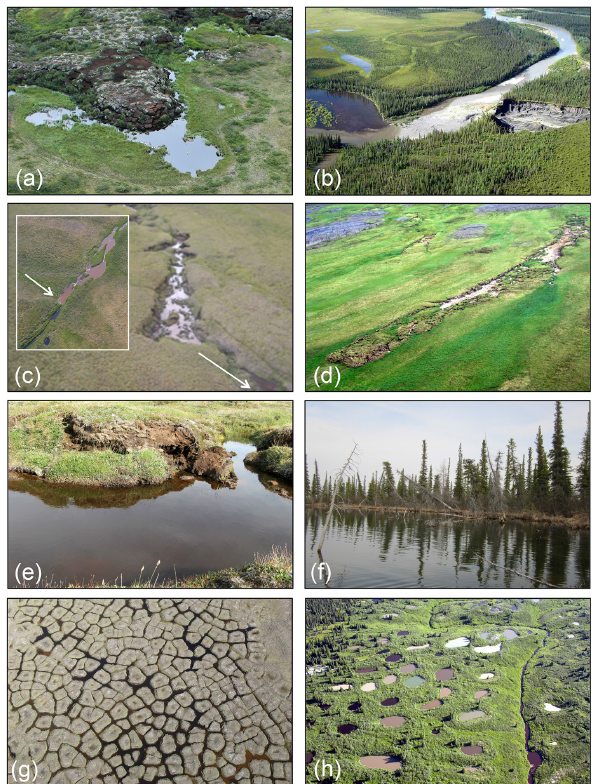
Figure 2. Photos of typical thermokarst processes: (a) Thermokarst lake SAS1, located in a sub-Arctic peat bog near Kuujjuarapik– Whapmagoostui, Québec, Canada. The water body lies next to a thawing, organic-rich palsa (permafrost mound), and is 25m in its maximum dimension. (b) Massive thaw slump on the Selawik River near Selawik, Alaska, US. Sediment discharge from the fea- ture has entirely blocked the river. Note the turbidity downstream. (c) Gully thermokarst on the Toolik River, Alaska, US, and im- pact on receiving stream (inset), (d) active layer detachment slides near the Anaktuvuk River burn area on the North Slope of Alaska, (e) trough pond on Bylot Island, Nunavut, Canada featuring active erosion, (f) thermokarst lakes in Mackenzie Delta, Northwest Ter- ritories, Canada, showing active shoreline slumping, (g) polygonal landscape on Bylot Island, showing ice-wedge trough ponds, and (h) thermokarst lakes and ponds with a wide range in colour near Kuujjuarapik-Whapmagoostui, Québec, Canada. Photo credits: (a) , Bethany Deshpande; (b) , Benjamin Crosby, (c, d) , William Breck Bowden; (e, g, h) , Isabelle Laurion; (f) , Suzanne